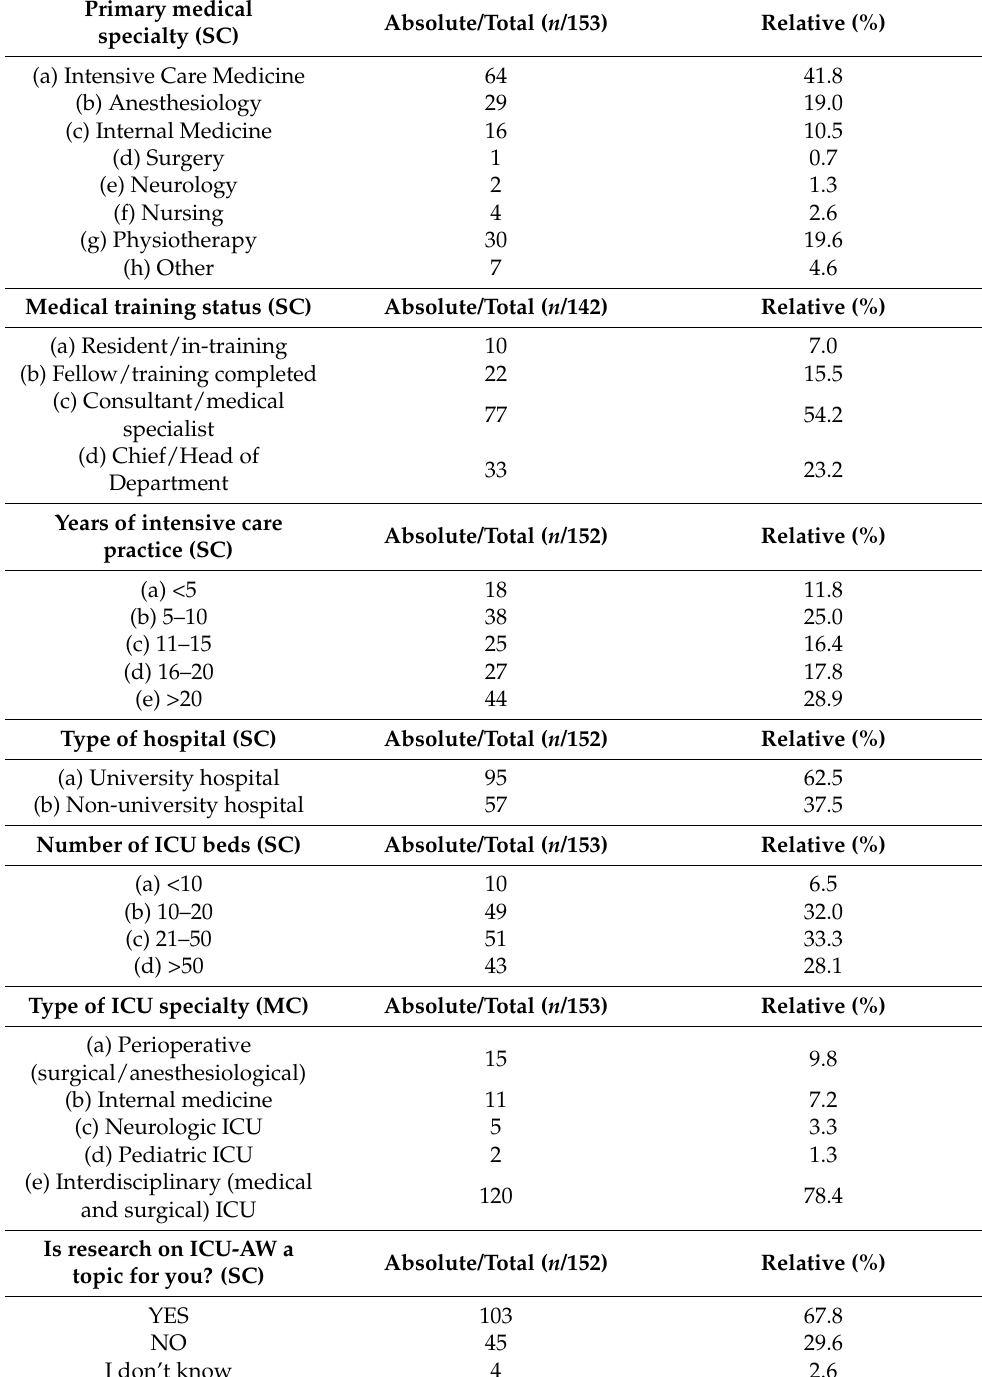
Table 1. Basic demographic data. Absolute counts indicate all participants who chose the particular answer of the corresponding question. Total counts indicate all study participants who answered the question at all. Relative counts indicate the ratio of absolute to total counts in